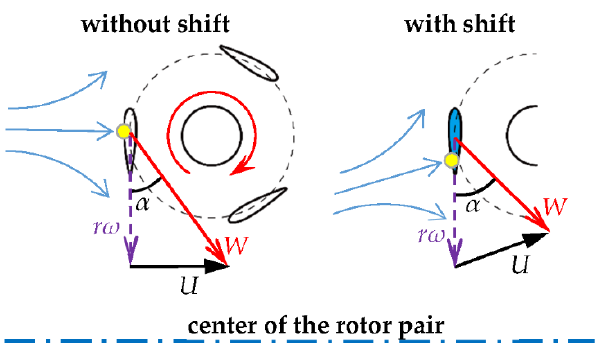
Figure 16. Effect of the movement (shift) of stagnation point on the relative velocity W and the angle of attack α of the model blade.